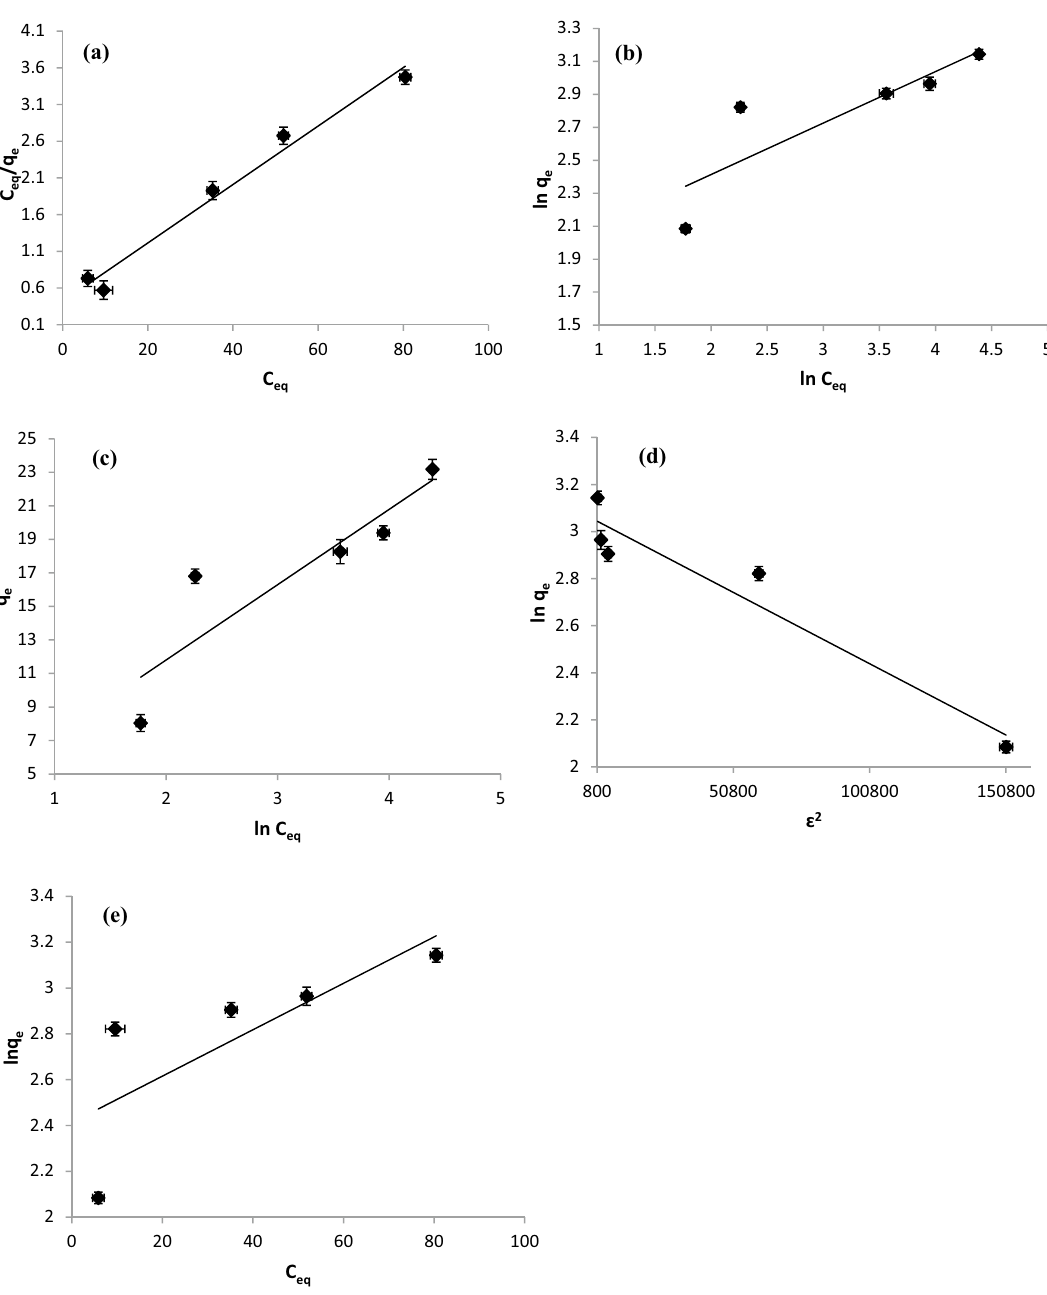
Figure 4. Biosorption isotherms of copper ions onto R. damascena leaves, including ( a ) Langmuir, ( b ) Freundlich, ( c ) Temkin, ( d ) Dubinin–Radushkevich and ( e ) Jovanovic models. Data is presented as average ± SE of three